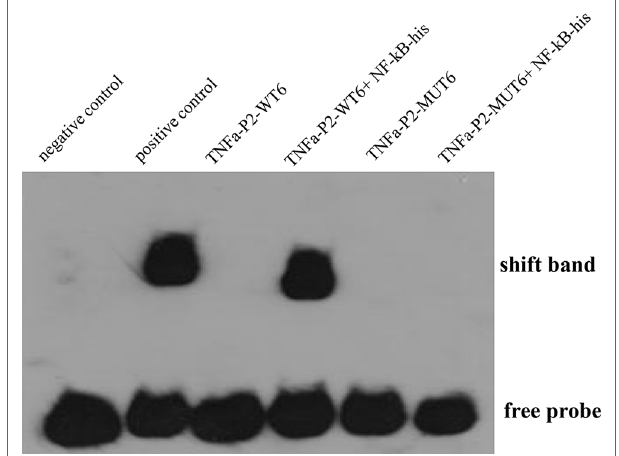
FIGURE 7 | Binding reactions of ToNF- κ B and the ToTNF α promoter. Biotin-labelled EMSA probes are incubated with lysates of HEK293T cells containing NF- κ B protein. WT, wild-type probe; MUT, mutated probe. Positive control indicates ToTNF α +Protein; negative control indicates ToTNF α